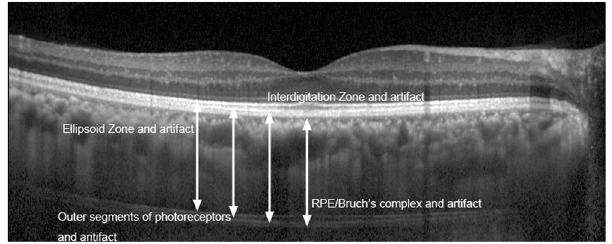
Figure 2. The linear artifact and corresponding retinal structures in EDI-OCT. The ellipsoid zone, the outer segments of photoreceptors, the interdigitation zone and RPE/Bruch’s complex corresponded to the four zones of linear artifact, respectively.